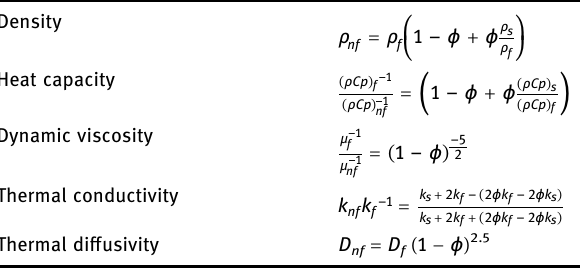
Table 1: The precise formulations for nano fl uid thermophysical characteristics ( see Khashi ’ ie et al. [ 39 ])